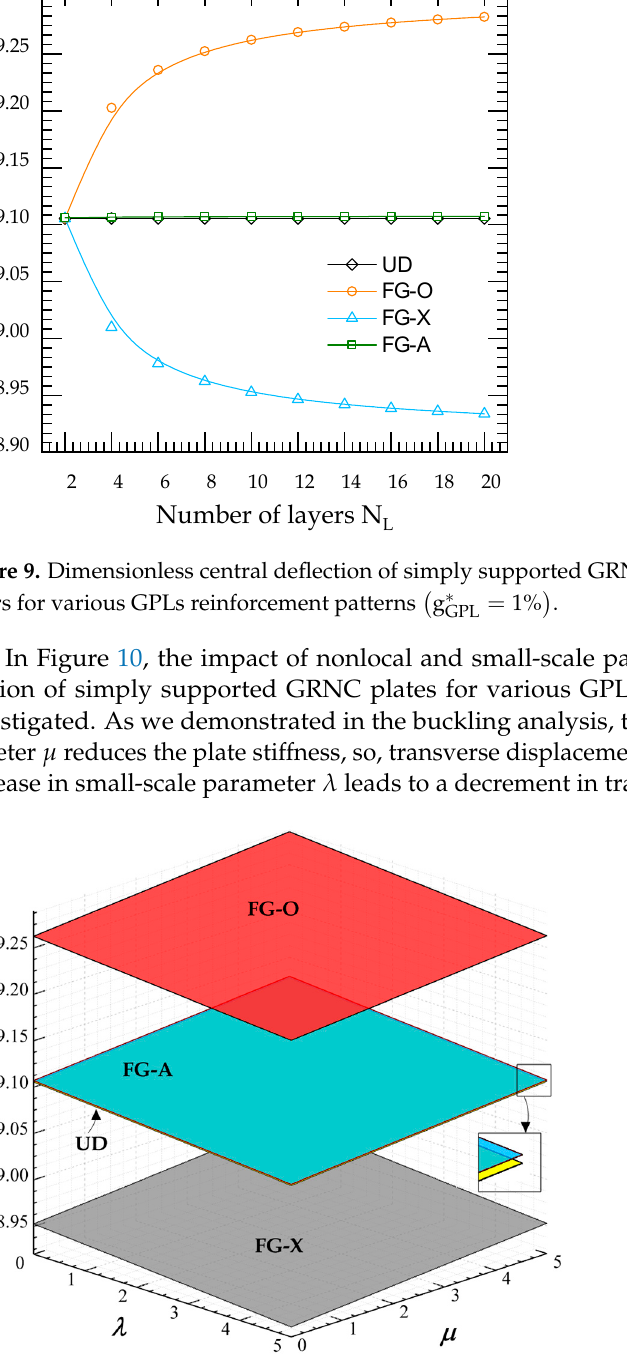
(cid:0) = 1% (cid:1) . g ∗ GPL